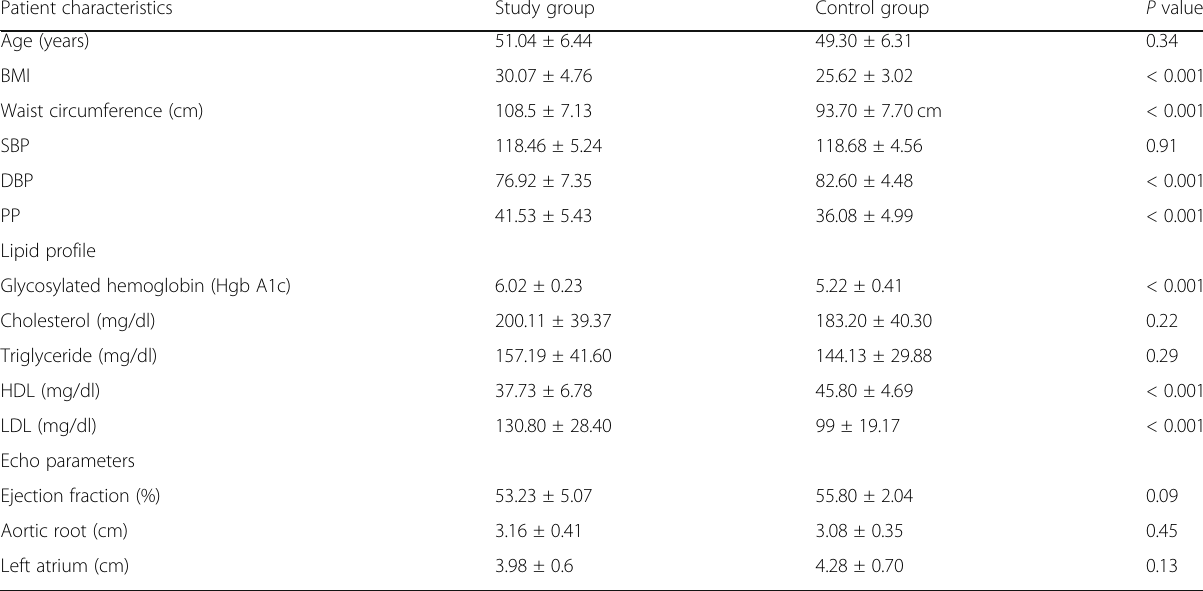
Table 1 Clinical characteristics of the study and control groups